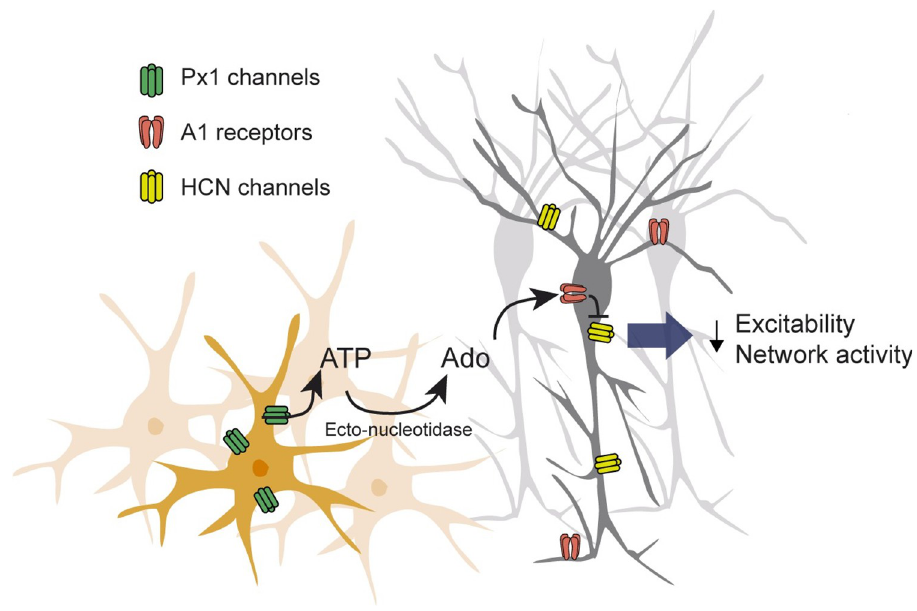
Fig 8. Mechanism of Px1-mediated modulation of network activity. Schematic diagram depicting the proposed mechanism through which astroglial Px1 channels signalling decreases population activity: Px1 channels release ATP, converted to adenosine, which binds neuronal A1 receptors. Subsequent intracellular signalling induces inhibition of HCN channels, leading to decreased excitability and population activity. Ado, Adenosine.